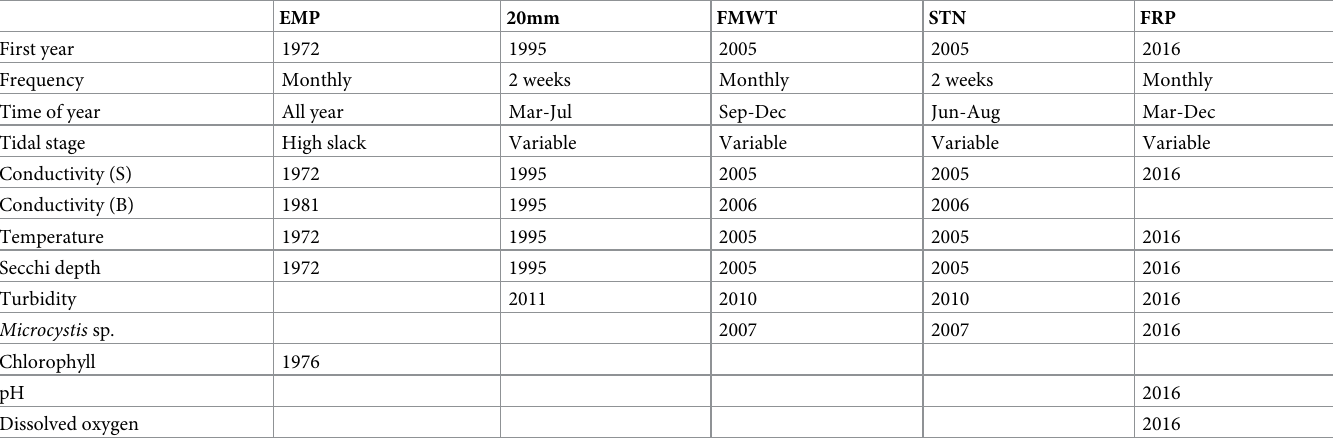
Table 1. Sampling design and start years for environmental variables measured by each monitoring survey.